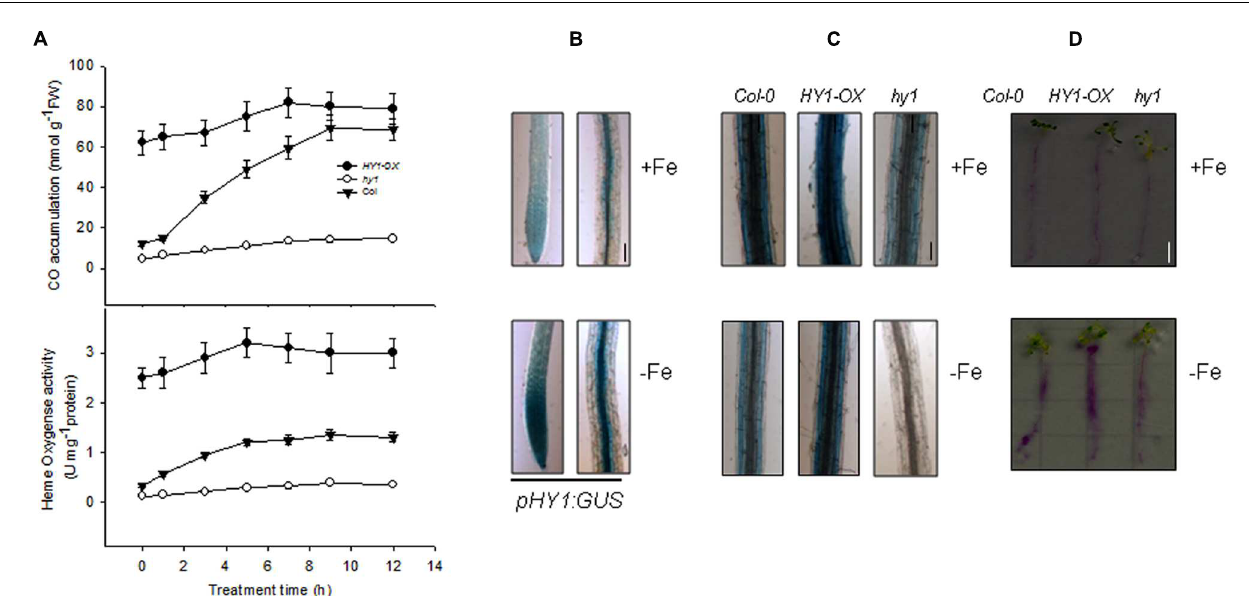
FIGURE 1 | Induction of heme oxygenase activity and CO generation by –Fe. (A) –Fe induced heme oxygenase activity and CO generation. Two-week-old wild-type Col-0, hy1 seedlings and HY1-OX lines were transferred to –Fe hydroponic medium, and heme oxygenase activity and CO generation were measured at the indicated time points. Data are the means ± SD ( n = 6). (B) –Fe induced the transcription of HY1 . Two-week-old wild-type Col-0 or transgenic pHY1:GUS seedlings were shifted to –Fe hydroponic medium, and the seedlings were subjected to GUS staining after 3 days of –Fe stress. Bar = 0.1 cm. (C,D) Perl staining analysis of Col-0, hy1, and 2-week-old HY1-OX plants subjected to –Fe stress. Two-week-old Col-0, hy1, and HY1-OX seedlings were shifted to –Fe liquid media for 1 week and the roots were analyzed using a ferrozine assay©, or to –Fe solid media containing Bromocresol Purple (D) for 1 day. Red indicates acidification. Bar = 0.5